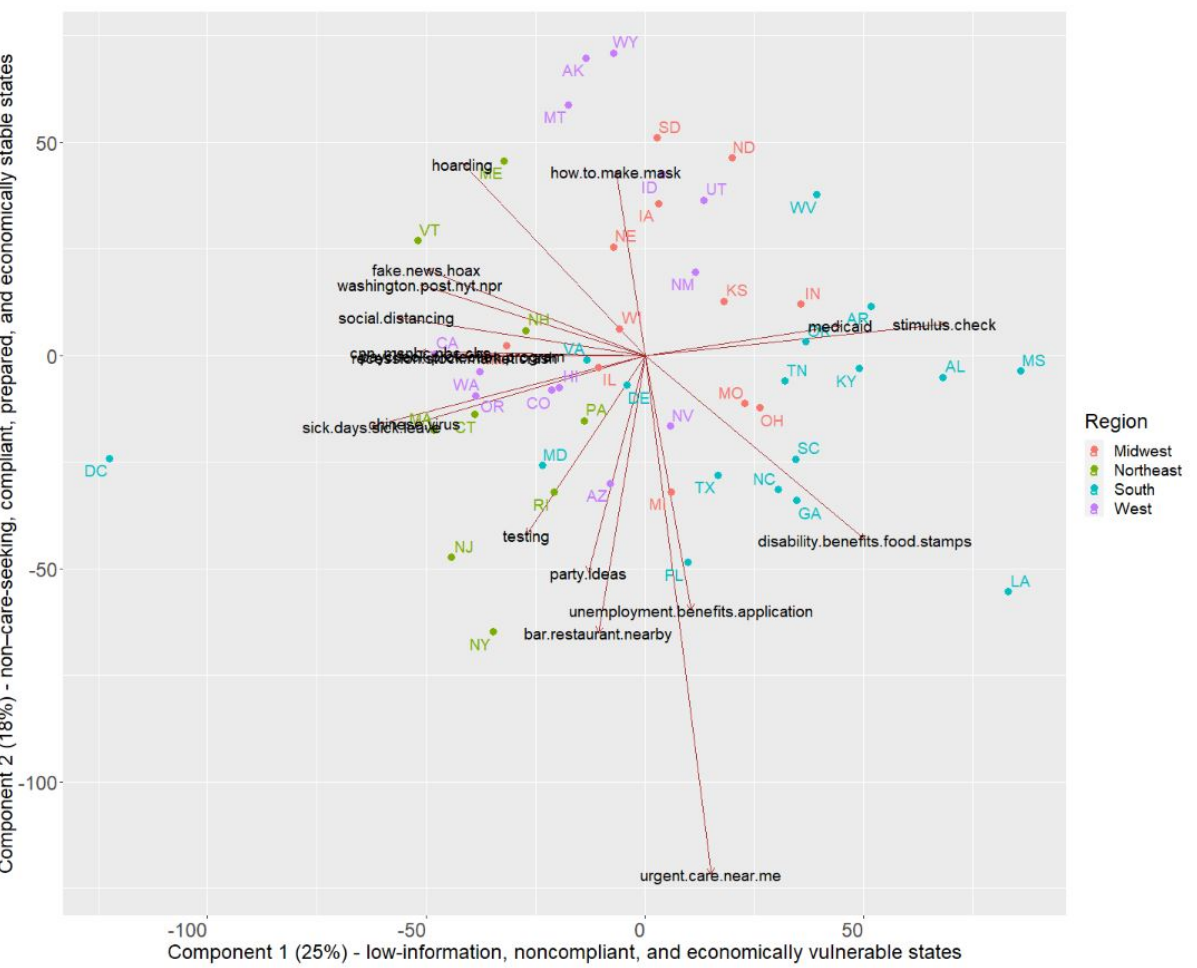
Figure 6. Scatterplot of state principal component analysis loadings and scores for the first two components, with the top queries shown as arrow vectors. Each arrow represents the relative weight of each query, and the direction indicates the points to the states that most exhibit this search pattern. The arrow direction measures correlation; arrows in the same direction are highly positively correlated, while divergent arrows in opposite directions are highly negatively correlated. Component 1 (x-axis) and Component 2 (y-axis) explain 25% and 18% of the variation (differences or patterns) in the data,